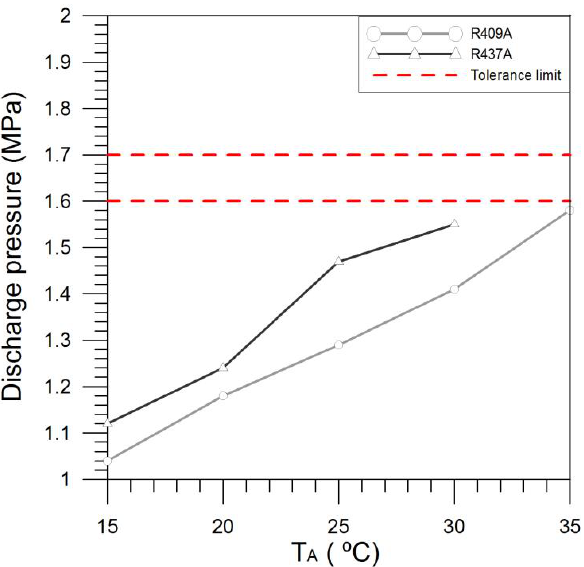
Figure 5: Effect of refrigerant flow rate on the compressor discharge pressure (Group B of